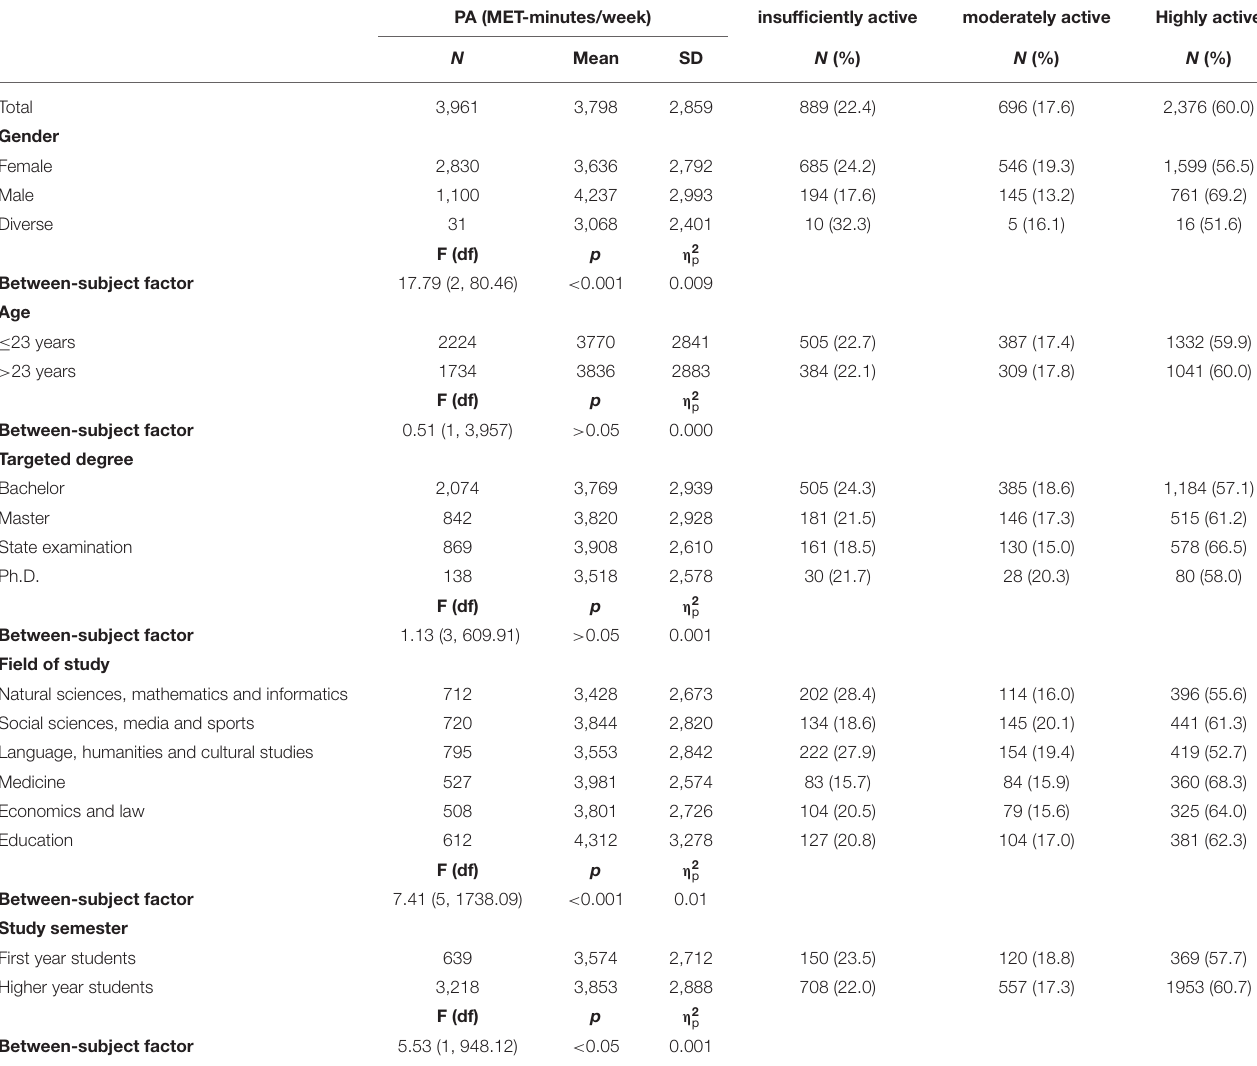
TABLE 3 | Means, standard deviations, and analysis of variance in PA.